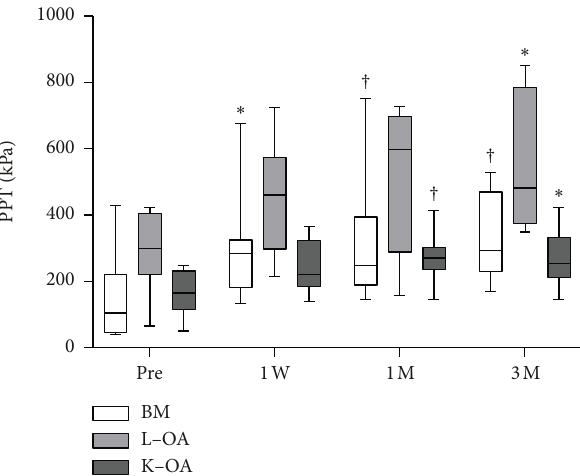
Figure 4: Pressure pain thresholds of patients at various time points. White, light gray, and gray bars indicate the PPTof patients with BM ( n � 8), L-OA ( n � 8), and K-OA ( n � 9), respectively. ∗ p < 0 . 05 versus pretreatment PPT; † p < 0 . 005 versus pretreatment PPT. PPT, pressure pain threshold; BM, bone metastasis; L-OA, lumbar facet joint osteoarthritis; K-OA, knee osteoarthritis; Pre, pretreatment; W, week; M,